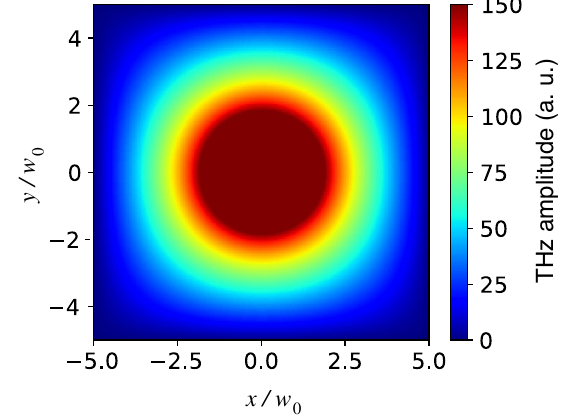
FIG. 6. Terahertz amplitude dependency on the transverse